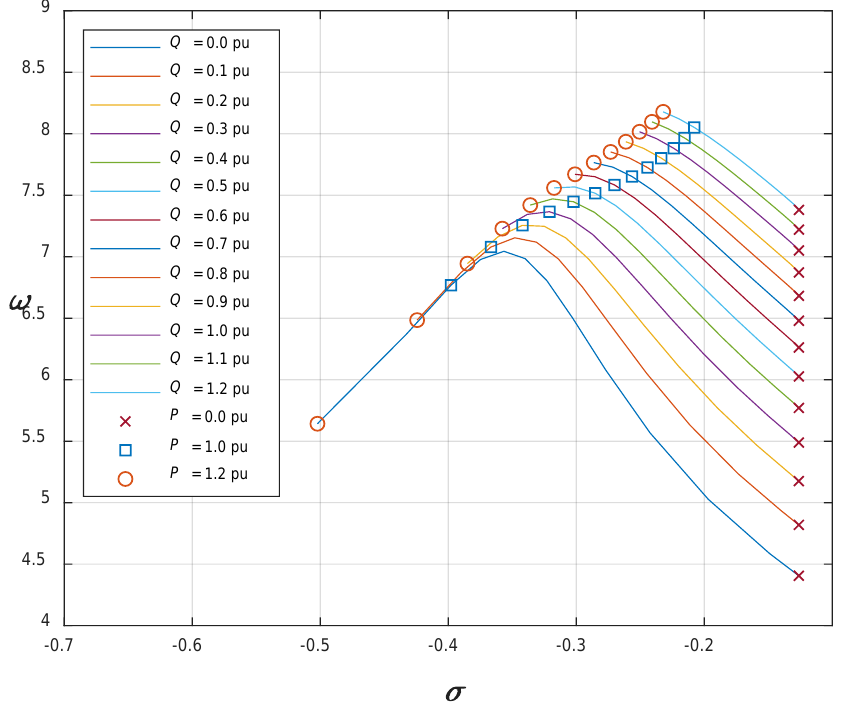
Figure 6. Eigenvalue loci of local mode of 160-MVA turbo-type synchronous generator without AVR.